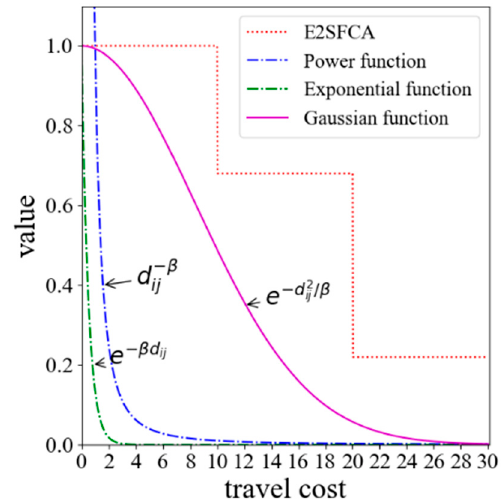
Figure 1. Major forms of impedance functions.